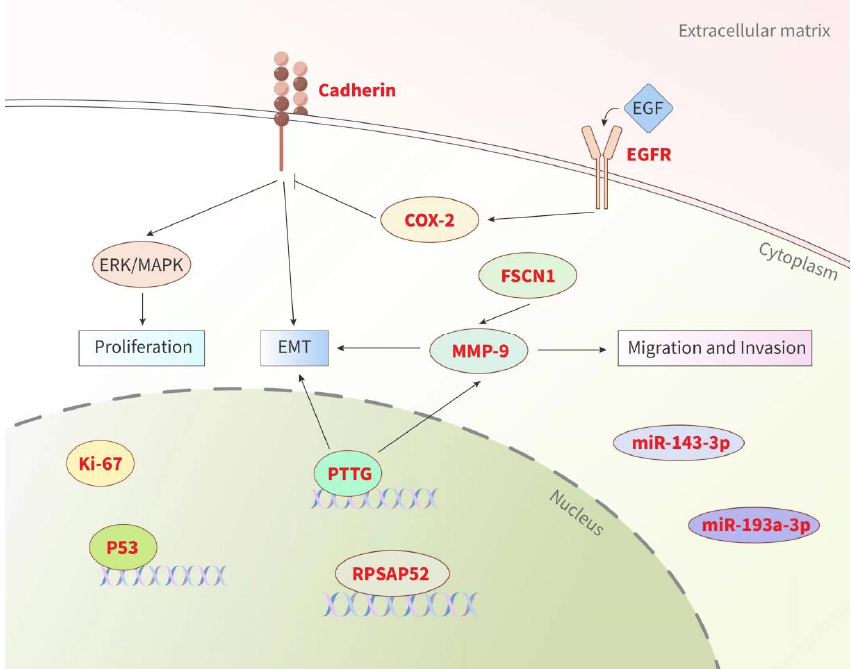
Figure 2. Summary of biological factors (biomarkers) for PA recurrence. Prognostic biomarkers (highlighted in red) from various sources could be used as valuable tools for predicting the recurrence of PAs (see text for details). Pituitary tumor transforming gene (PTTG), matrix metalloproteinase (MMP), cyclooxygenase-2 (COX-2), epidermal growth factor receptor (EGFR), fascin actin-bundling protein 1 (FSCN1), epithelial mesenchymal transformation (EMT), extracellular signal-regulated kinase (ERK), mitogen-activated protein kinase (MAPK).